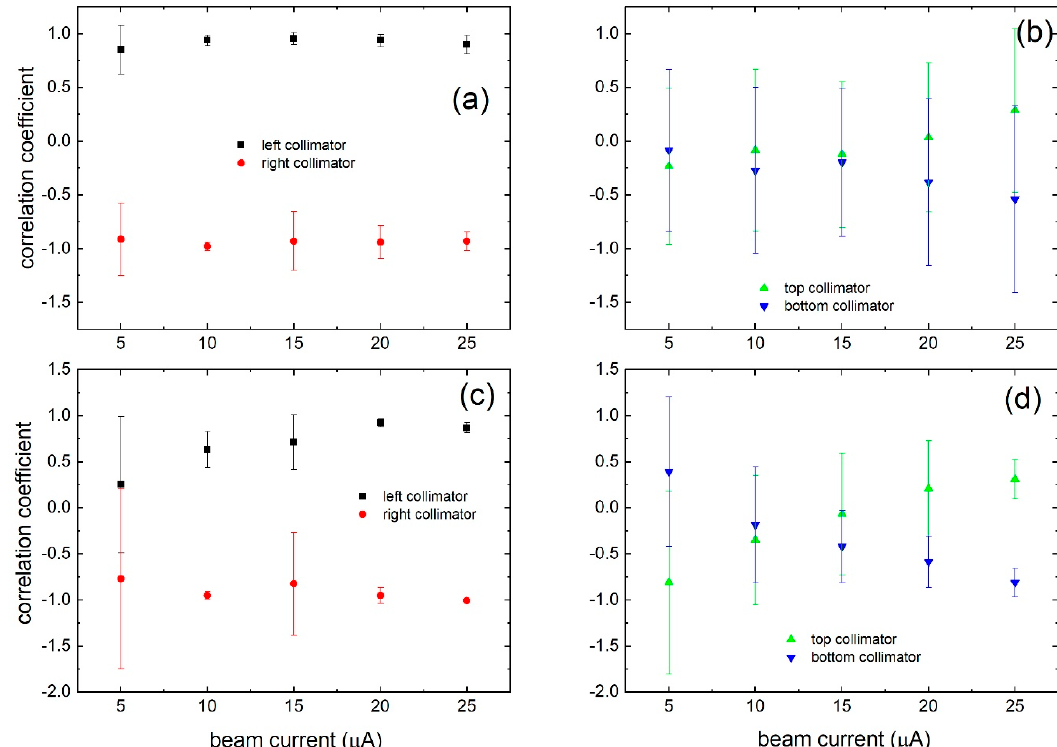
Figure 6. ( a ) Correlation coefficients as a function of beam current on target for regular steering up to 3 µA on the right and left collimator and ( b ) on the top and bottom collimator. ( c ) Correlation coefficients as a function of beam current on target for intense steering up to 5 µA on the right and left collimator and ( d ) on the top and bottom collimator.